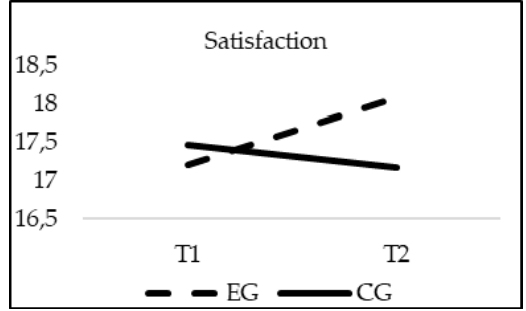
Figure 6. Interaction effects of group (EG-CG) and time (T1-T2) in Satisfaction.